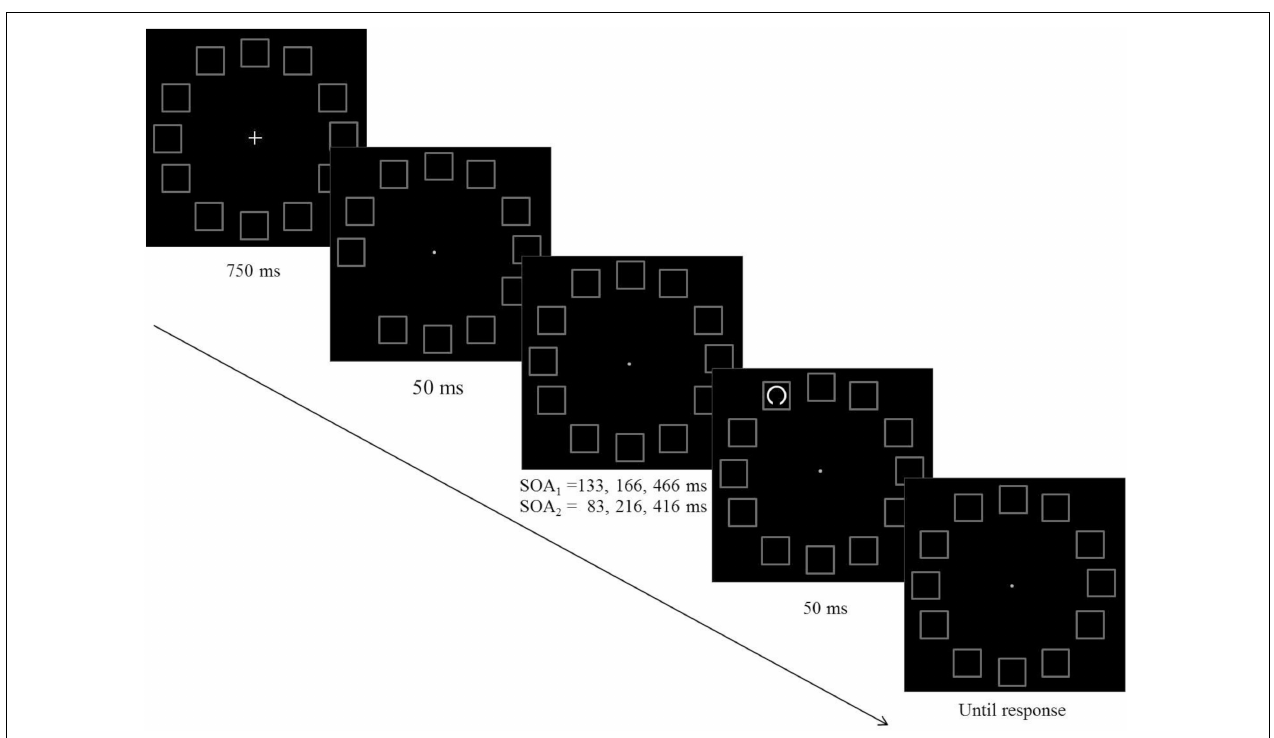
FIGURE 1 | A schematic example of the sequence of events in Experiments 1 (SOA 1 ) and Experiment 2 (SOA 2 ).